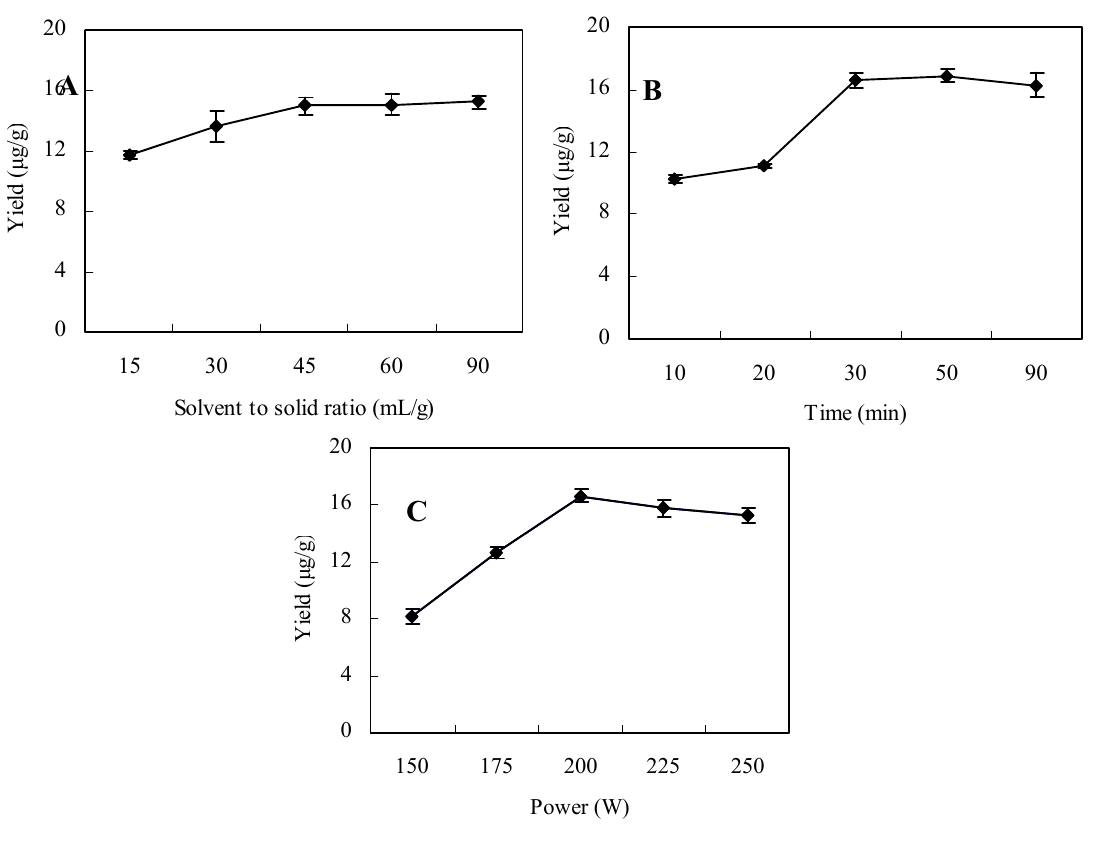
Figure 1. Effect of extraction conditions on the yield of